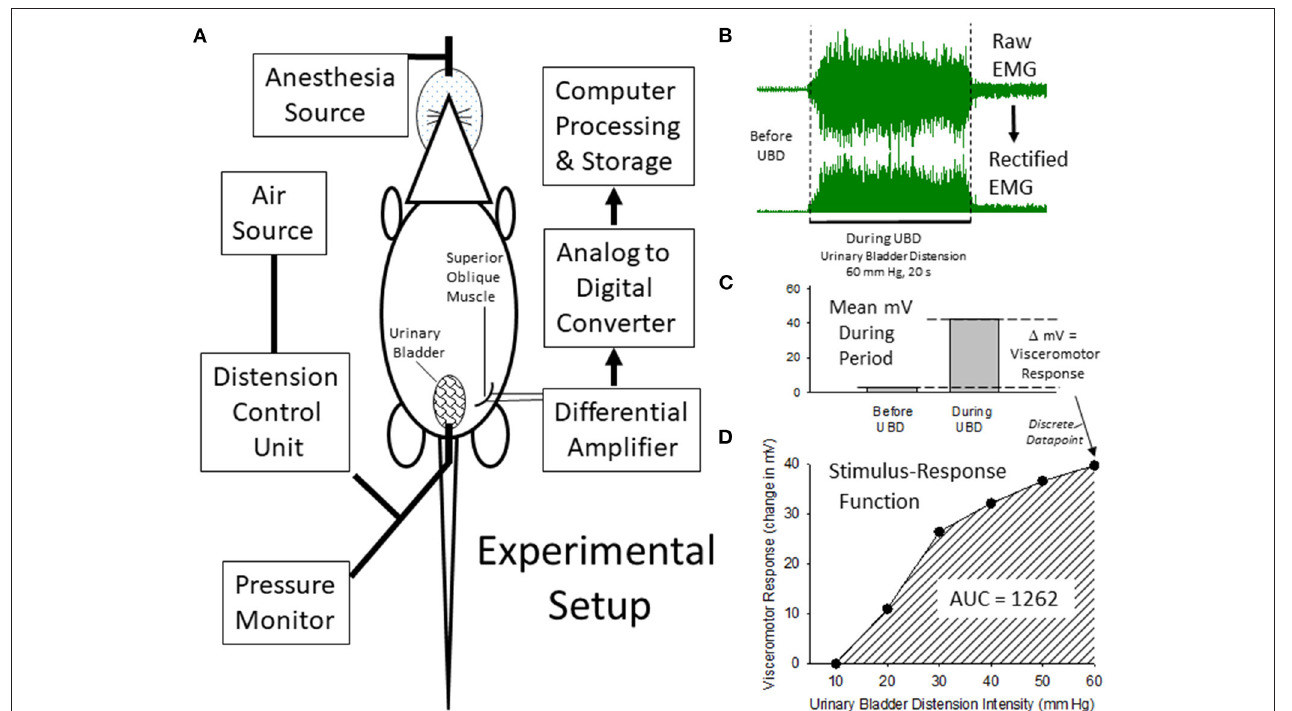
FIGURE 1 | Description of Experimental Setup and Quantitiatve Analysis. (A) is a graphical illustration of the equipment and animal resources used for the generation of visceromotor responses to urinary bladder distension (UBD). Air is used to distend the bladder via a transurethral intravesical catheter. Responses are measured as electromyograms (EMG) of the superior oblique abdominal musculature. An example of a digitized EMG before and during UBD at an intensity/duration of 60mm Hg/20 secs is given in (B) as well as its rectified transformation (all negative values made into positive values of equal intensity). These EMG responses were then quantified as the difference between the mean voltages of EMG activity before and during the 20s of UBD (C) to generate a discrete data point that was part of an overall Stimulus-Response Function (D) characterizing the individual rat’s visceromotor responses to graded UBD. An Area-Under-the-Curve (AUC) statistic related to the Stimulus-Response Function could then be generated which was representative of the overall vigor of the visceromotor responses.